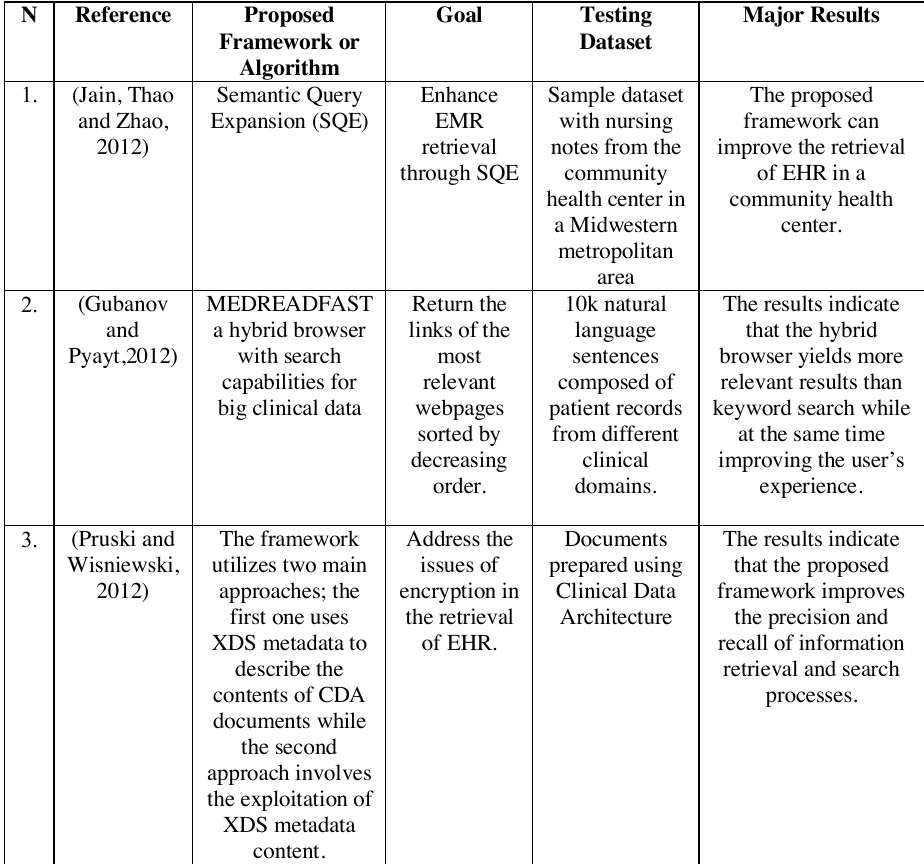
Table 1. Summary of Related